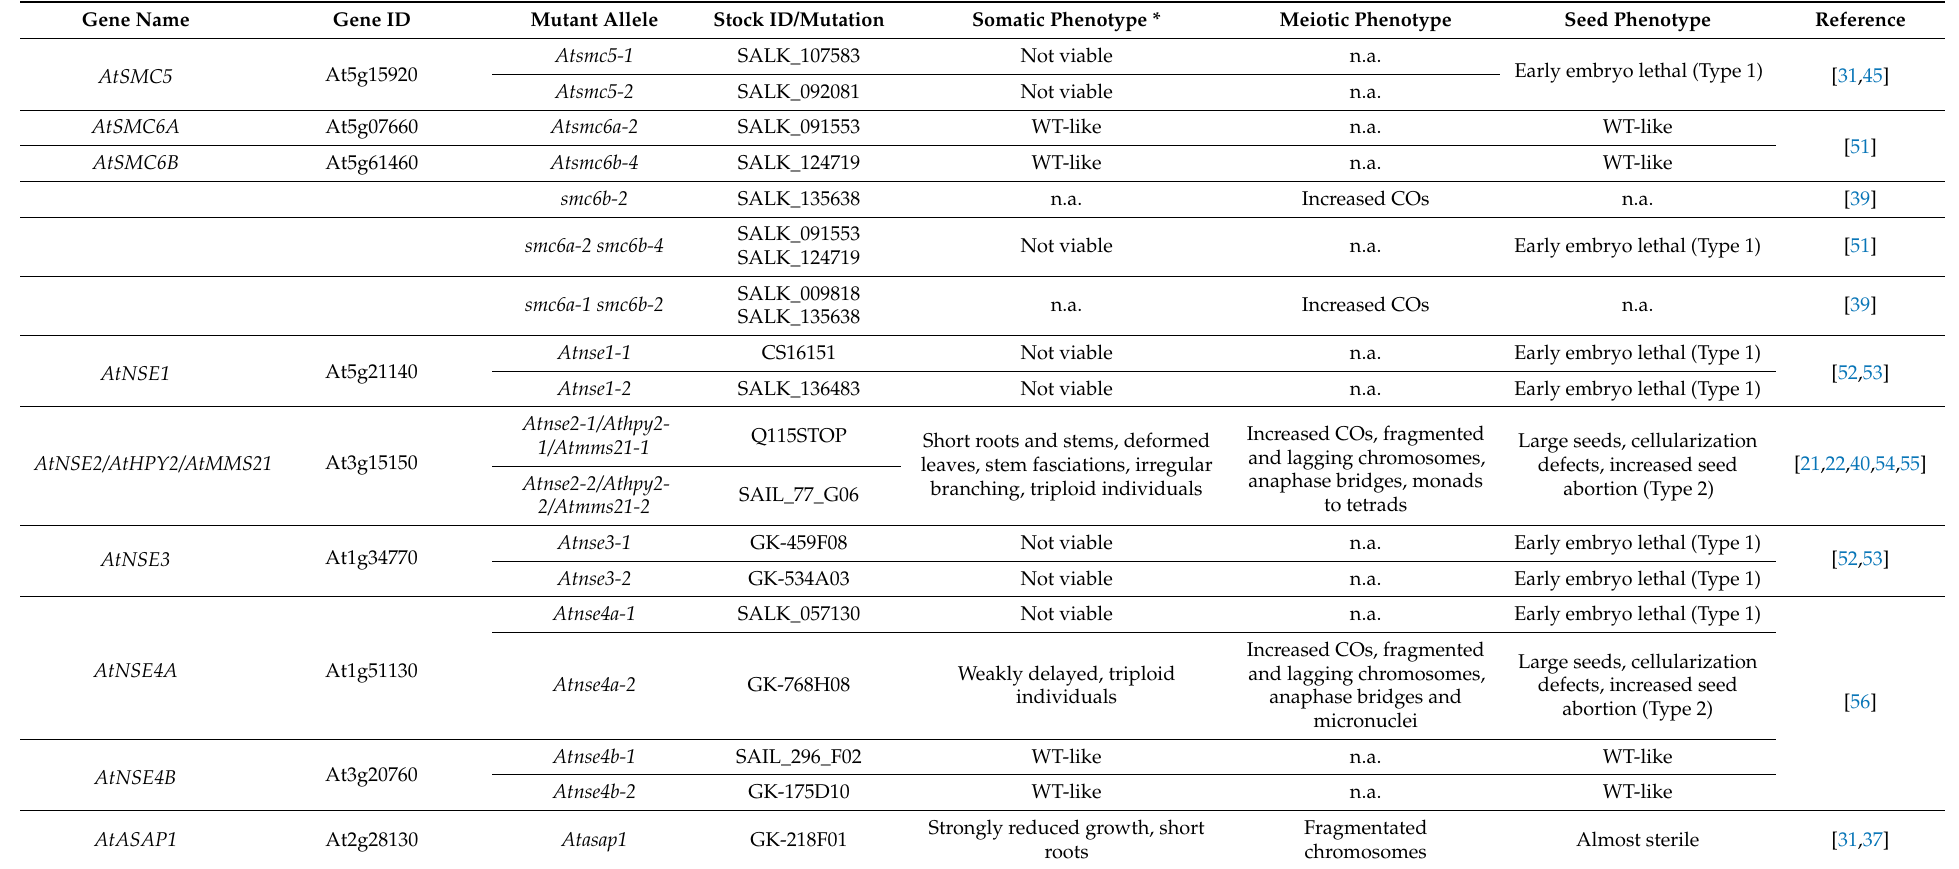
Table 1. The phenotypes of Arabidopsis SMC5/6 complex mutants. At— Arabidopsis thaliana , Zm— Zea mays , Os— Oryza sativa , *—under standard growth